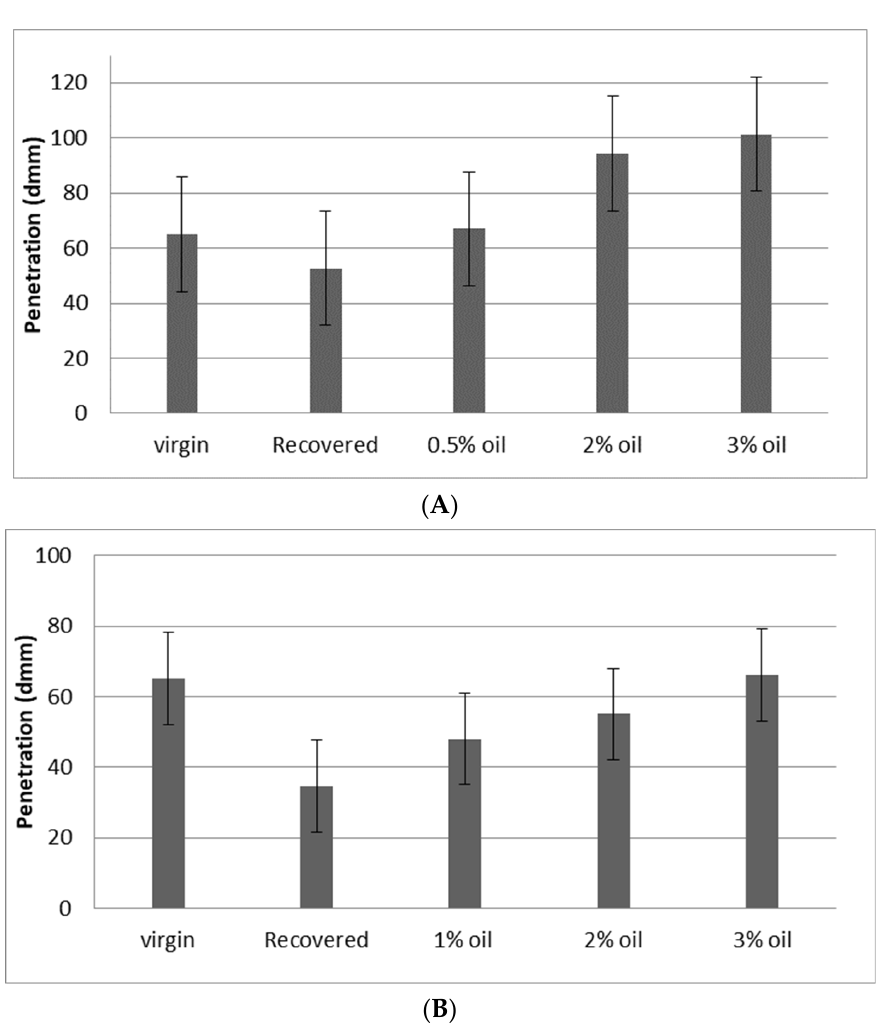
Figure 5. Penetration of virgin, recovered, and rejuvenated bitumen with WEO contents. ( A ) RCRD recovered aged binder; ( B ) RNCCD recovered aged binder.